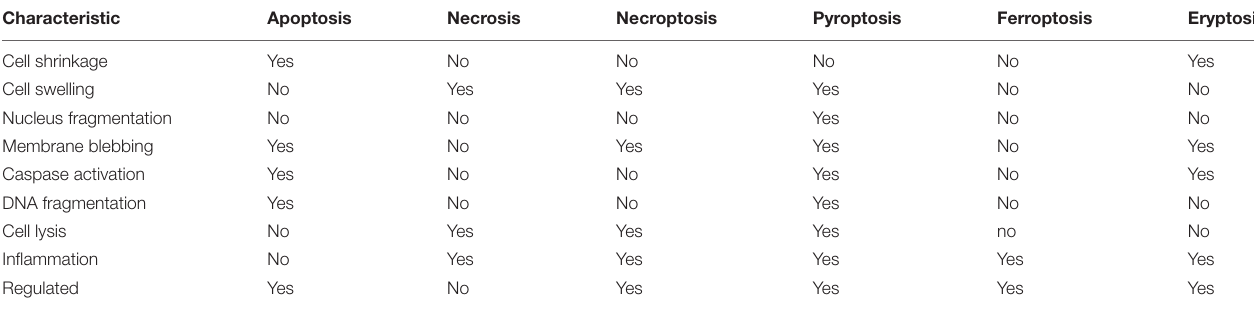
TABLE 1 | Characteristics of various regulated modes of cell death.